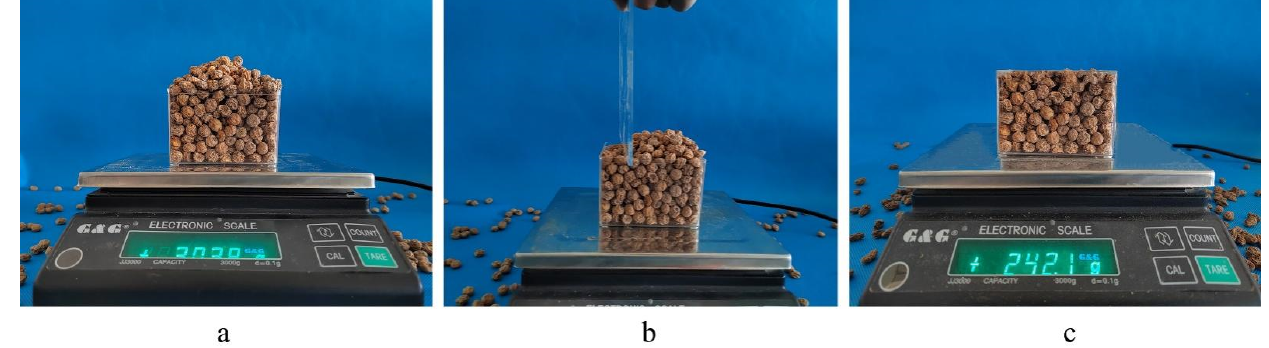
Figure 20. ( a – c ) Bulk density test of the Cyperus esculentus seeds.